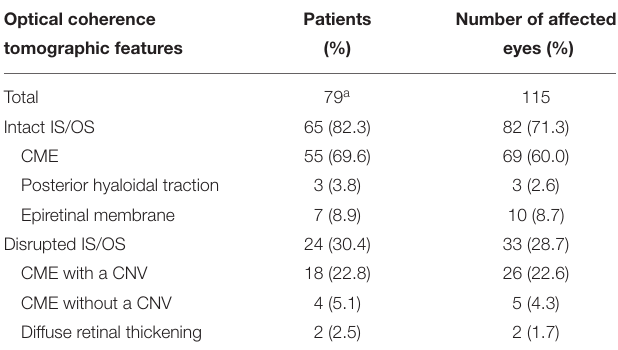
TABLE 1 | Optical coherence tomographic features of ME in eyes with VKH